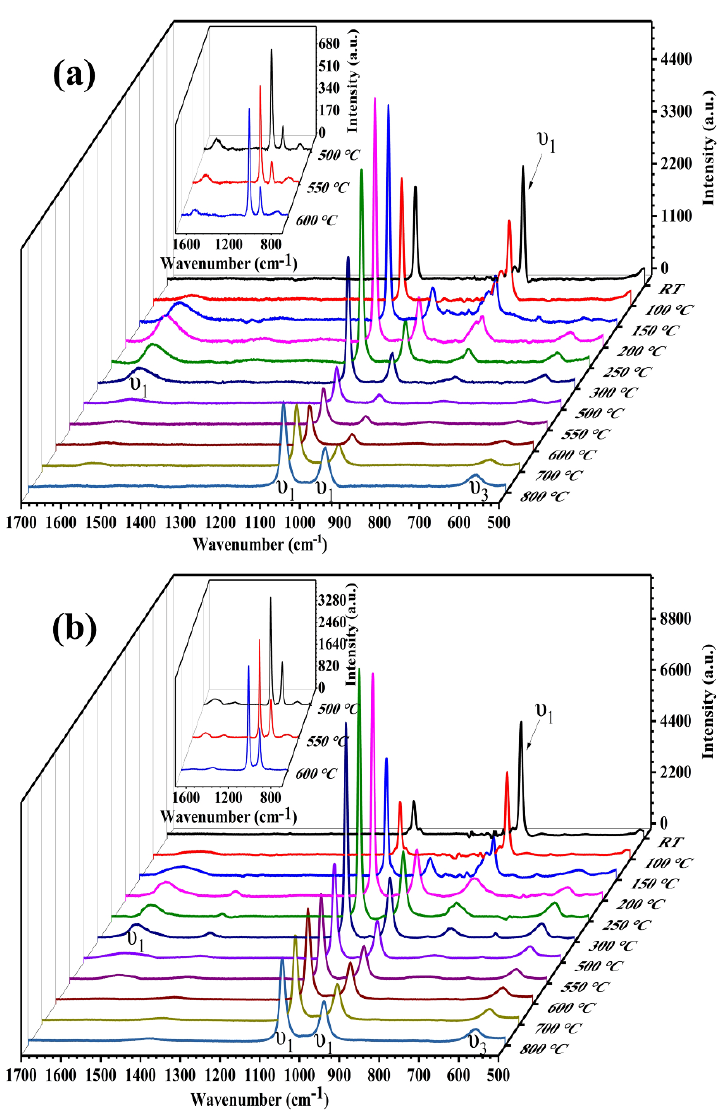
Figure 4. In situ Raman spectra of ( a )10(LiNa)90Na and ( b )10(LiNaK)90Na in the 80% CO 2 –20% N 2 atmosphere.